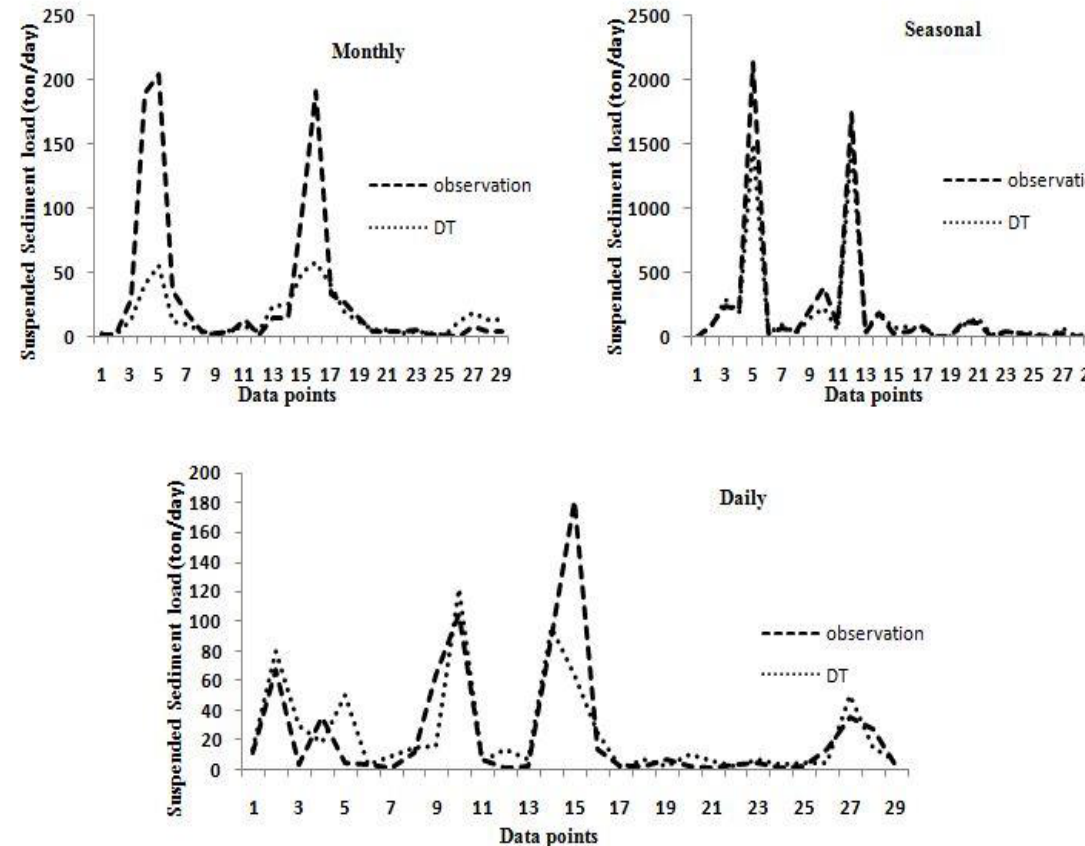
Fig. 1. Comparison of DT model and observational